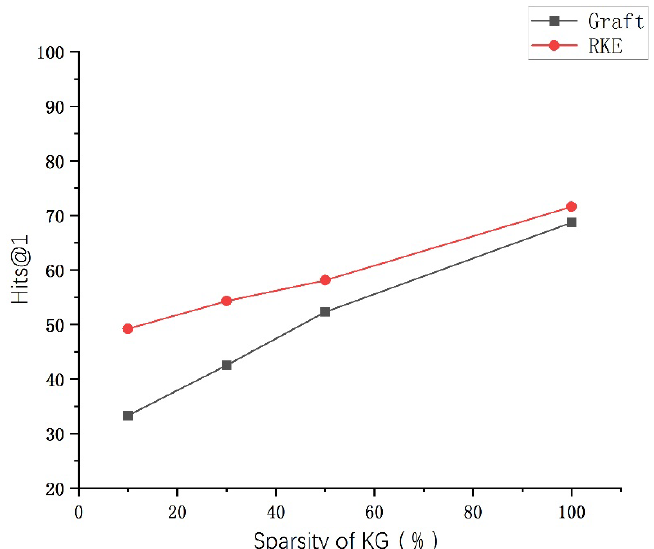
Figure 9. Experimental comparison diagram. We chose the KGs with 10%, 20%, and 50% sparsity for comparison experiments.